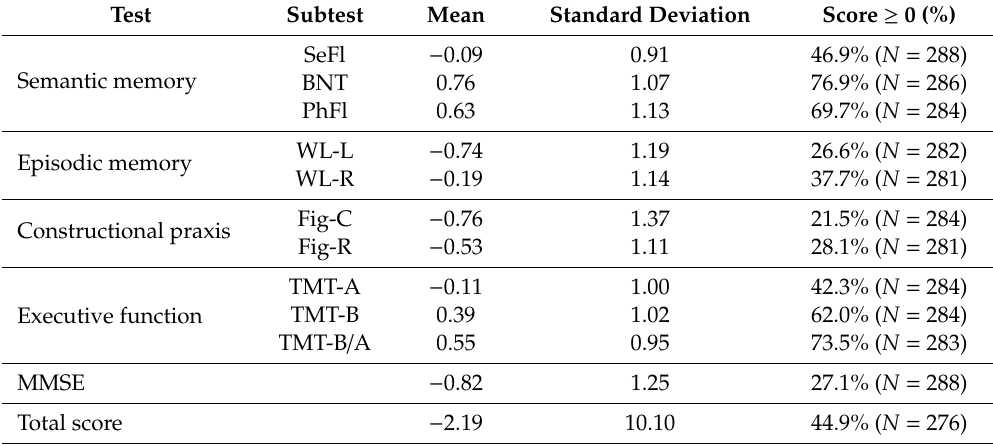
Table 4. Description of the CERAD-Plus scores in the study